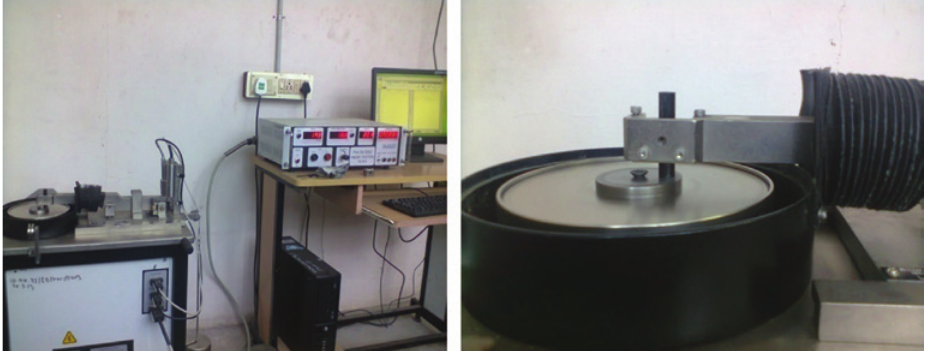
Figure 4: Pin-on-disc wear testing arrangement.